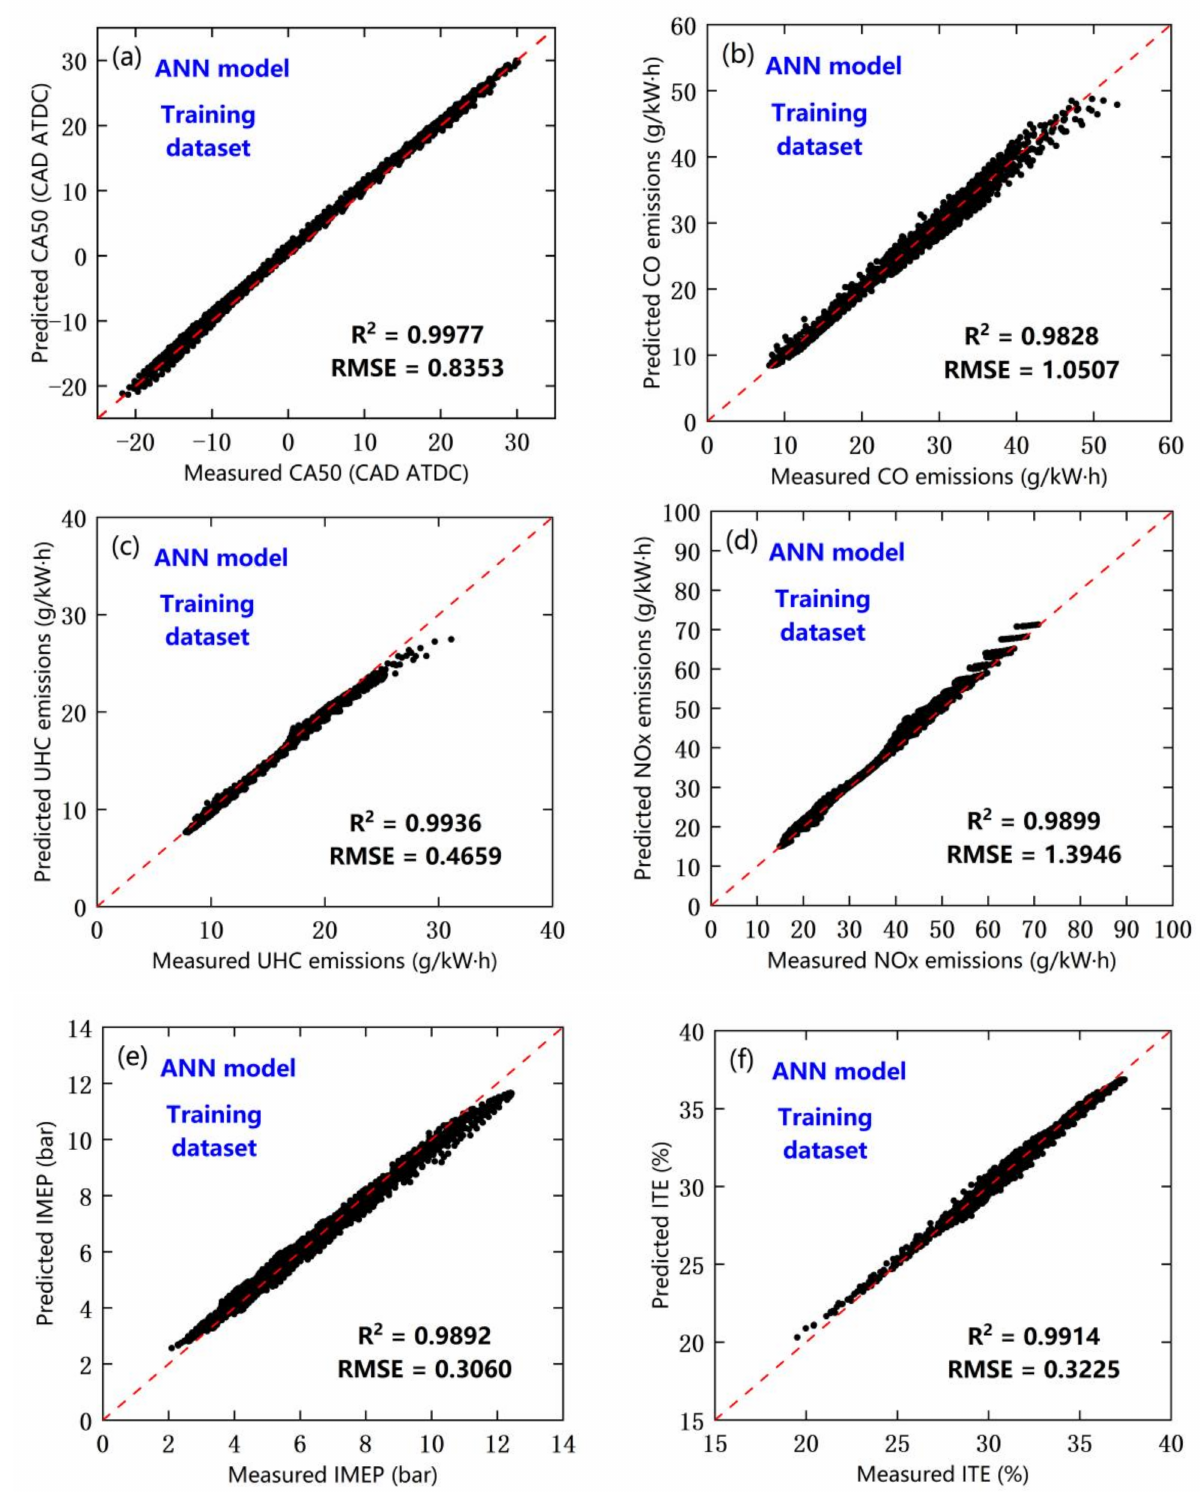
Figure 3. Comparison of ANN predicted performance and emissions with actual value for the training dataset: ( a ) CA50, ( b ) CO, ( c ) UHC, ( d ) NOx, ( e ) IMEP, ( f )